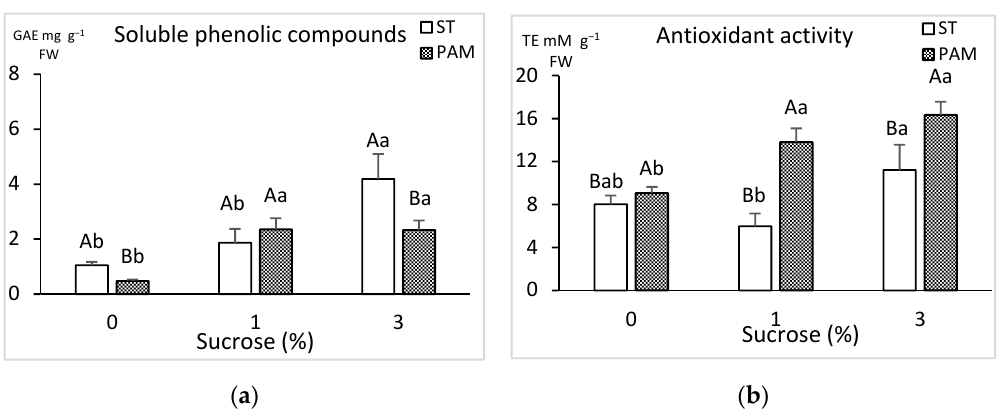
Figure 9. Effect of growth conditions and sucrose supplementation on the phenolic and antioxidant concentration of leaves of genotype CBP cultured in RITA© with 6 immersions/day. ( a ) Total soluble phenolics and ( b ) total antioxidant activity. Different uppercase letters indicate significant differences in relation to the growth conditions, and different lowercase letters indicate significant differences in relation to the sucrose supplementation ( p < 0.05). ST: standard conditions, PAM: photoautotrophic conditions and FW: fresh weight. GAE: gallic acid equivalents and TE: Trolox equivalents.